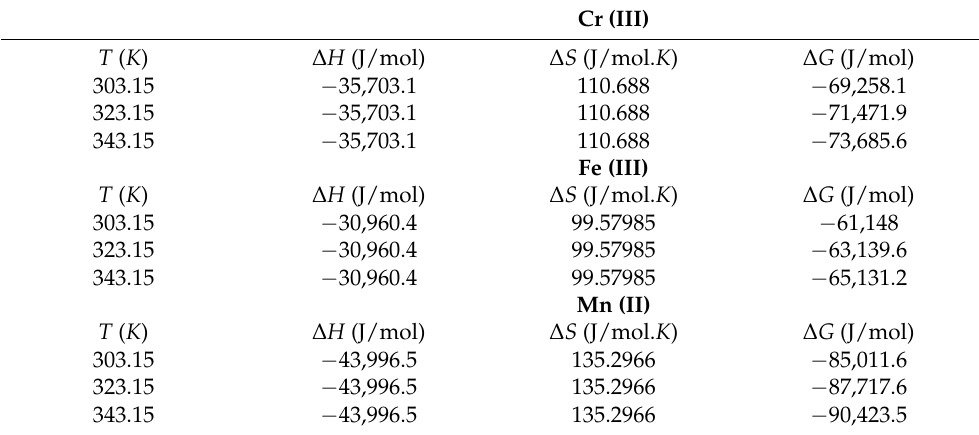
Table 5. Thermodynamic constants for the adsorption of Cr (III), Fe (III), and Mn (II) on the